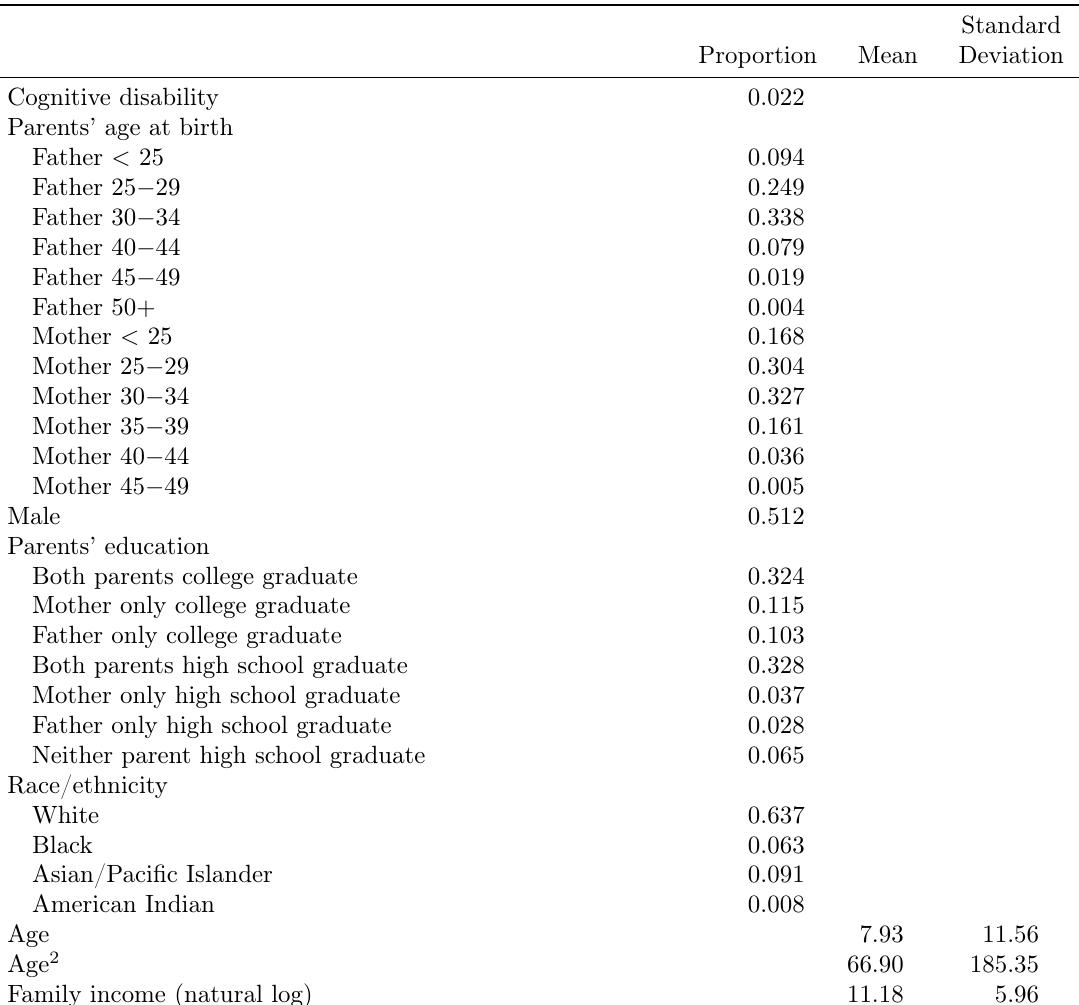
Table 1: Variables used in the analysis